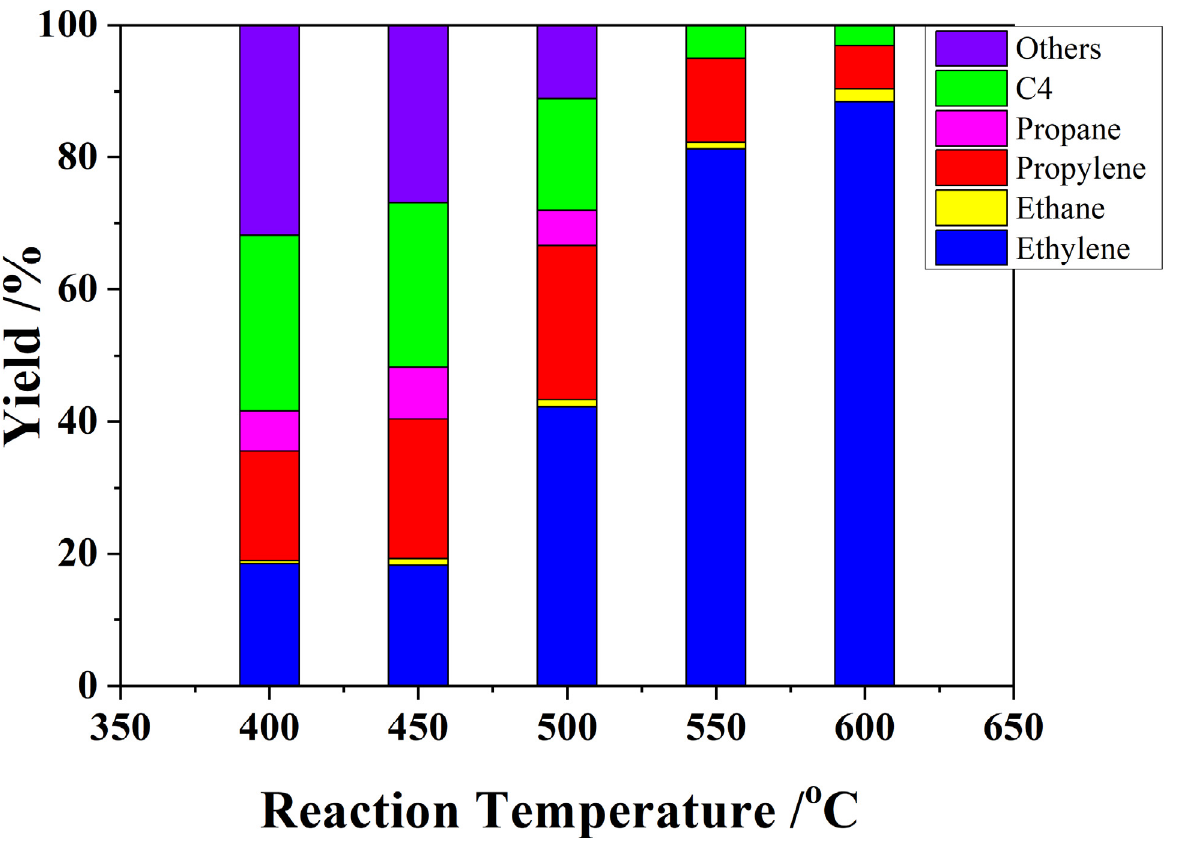
Figure 4. ETO reactions on H-ZSM-5(80) at different temperatures. W/F = 0.0025 g/cm 3 ·min − 1 , EtOH concentration, 50%.